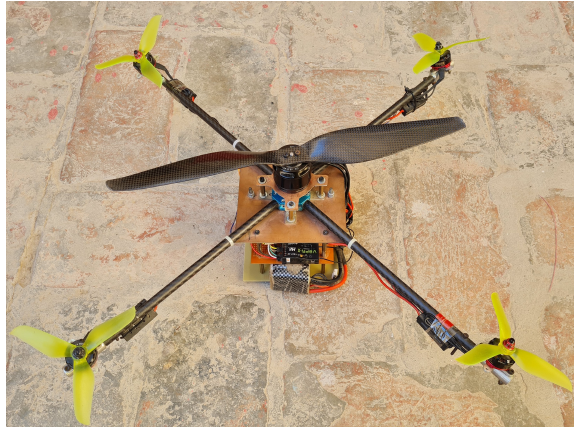
Figure 5. Heterogeneous multirotor prototype.